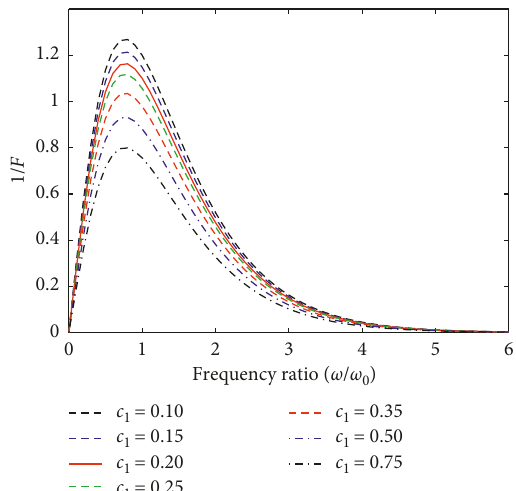
Figure 18: Chaotic threshold curve with different c k 1 � 1, k 3 � 1, h � 0.5, and p � 0 . 5).